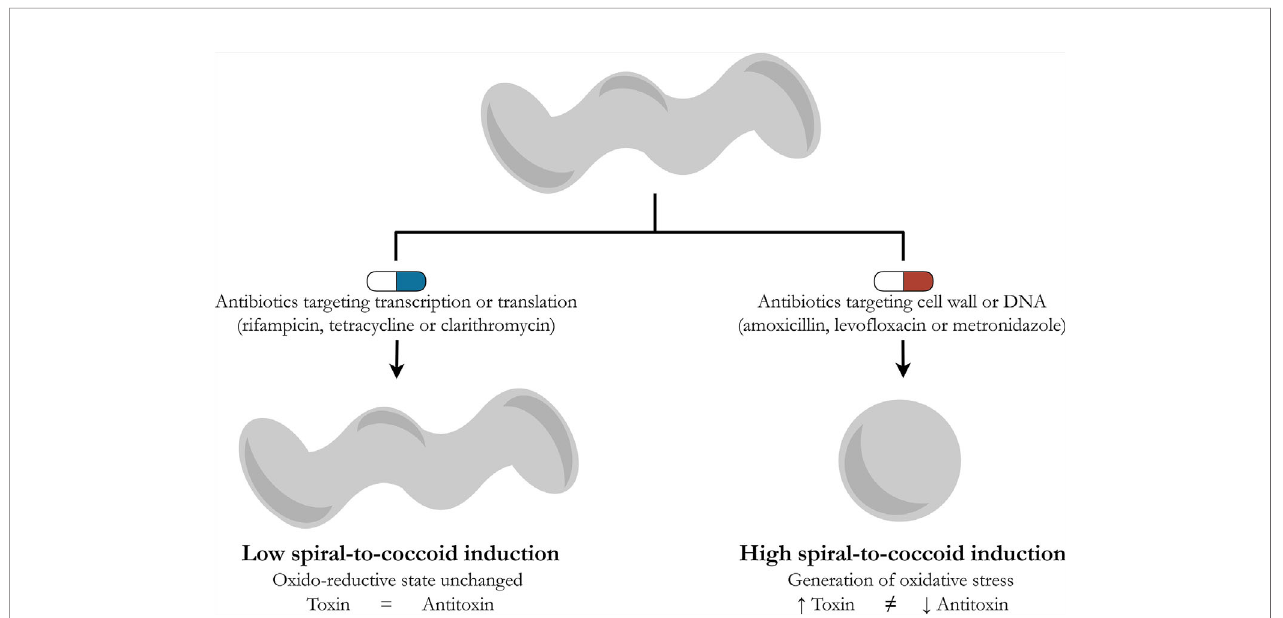
FIGURE 1 | Schematic drawing presenting a hypothetical model describing differences in the potential of antibiotics to generate the spiral-to-coccoid transformation in H. pylori . In the routine therapy of H. pylori , the following antibiotics are used: rifampicin (transcription), tetracycline and clarithromycin (translation), metronidazole and levo fl oxacin (the DNA structure or replication), and amoxicillin (the cell wall) (Jones et al., 2008; Francesco, 2011; Nishizawa and Suzuki, 2014). Based on reports showing the ability of bactericidal antibiotics to stimulate oxidative stress in microbial cells (Kohanski et al., 2007; Brynildsen et al., 2013; Dwyer et al., 2014; Belenky et al., 2015; Lobritz et al., 2015; Li et al., 2017) and the results of Mortaji et al. (2020), demonstrating the oxidative stress-dependent induction of the toxin-antitoxin system in H. pylori , a hypothetical model integrating the above observations has been proposed. Antibiotics acting on transcription and translation (rifampicin, tetracycline or clarithromycin) have a marginal effect on the oxido-reductive state of bacterial cells and therefore do not signi fi cantly affect the toxin-antitoxin balance. The opposite situation is suggested for antibiotics targeting the cell wall or DNA (amoxicillin, levo fl oxacin or metronidazole), all of which stimulate the accumulation of reactive oxygen species in bacterial cells and the oxidative stress-related disturbance of the toxin-antitoxin balance in favor of the former. The increased production of this toxin is accompanied by the conversion of H. pylori into spherical